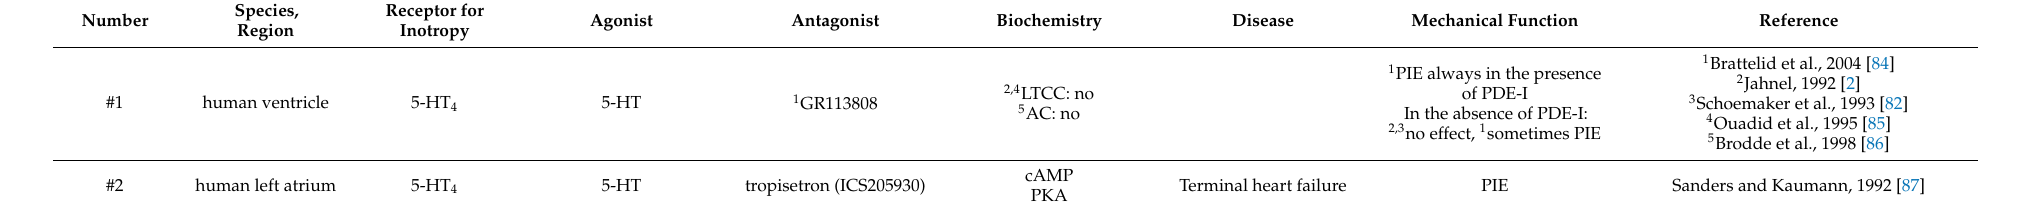
Table 1. Synopsis of 5-HT receptor function in the hearts of several species. We differentiate species, the region or tissue in this species, the agonists and antagonists tested in that region, the mechanical response (positive inotropic effect: PIE), positive chronotropic (PCE), no measurable response (NR), biochemical measurements for signal transduction of the 5-HT 4 -receptor, in human samples with underlying disease (coronary heart disease (CAD), heart failure (HF), normorhythmia (SR), chronic atrial fibrillation (CAF), paroxysmal atrial fibrillation (PEF), Mice with cardiac specific overexpression of the 5-HT 4 -receptor (5-HT 4 -TG) or wild type littermates (WT); No: no effect; PIE: positive inotropic effect, PCE: positive chronotropic effect; cAMP: increase in the heart content of cAMP (3 (cid:48) ,5 (cid:48) -cyclic adenosine monophosphate); PKA: increase in the activity ratio of cAMP dependent protein kinase. If: increase in current through funny channel. LA: isolated left atrium; RA: isolated right atrium; LTCC: current through the L-type calcium ion channels in the appropriate tissue was increased by 5-HT. Tropisetron was initially called SB205930. AC: cAMP producing activity of adenylate cyclase was found enhanced. Ve: ventricle, usually papillary muscles were studied. PDE-I: in the presence of a phosphodiesterase inhibitor, usually isobutylmethylxanthine. PLB-P: increase in phosphorylation state of phospholamban, TnI-P: increase in the phosphorylation state of the inhibitory subunit of troponin. Superscripted number in the last column are correspondent with numbers in previous columns, indicate for instance in which citation this drug was used or this enzyme was